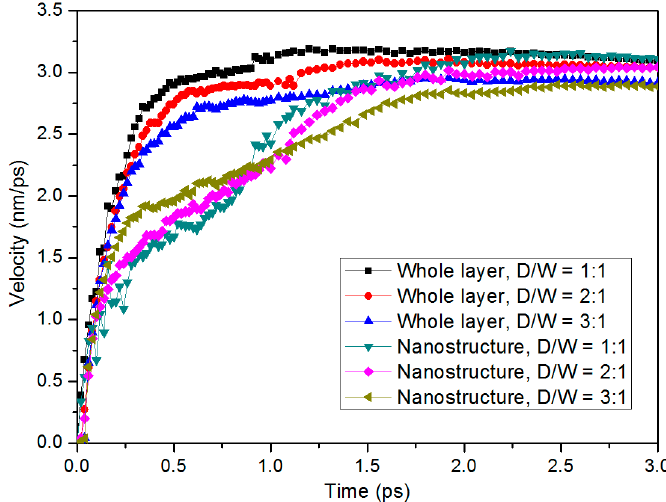
Figure 4. Velocities of the whole PP layer and the PP nanostructure during the demolding process with different D/W.